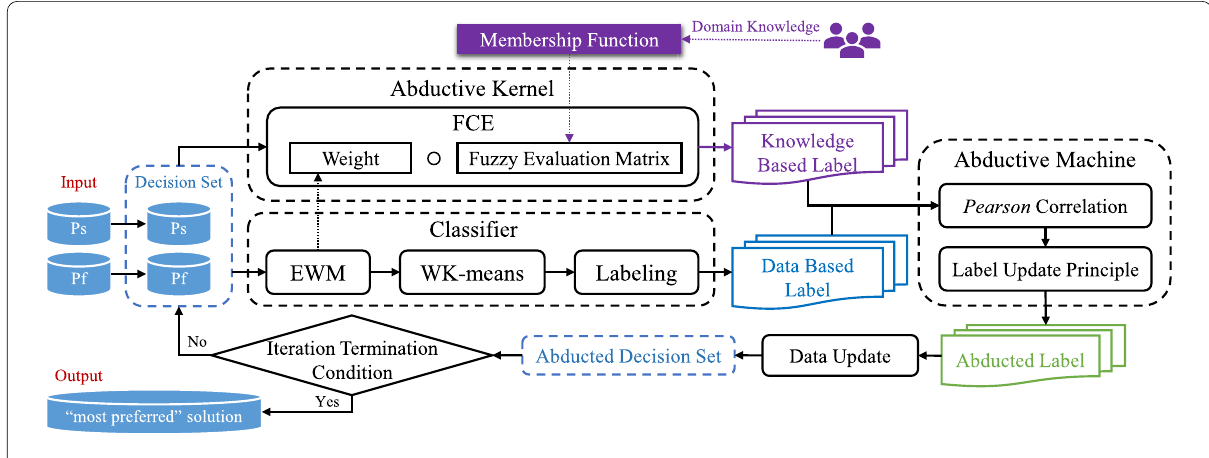
Figure 3 Collaborative decision-making method based on G-ABL